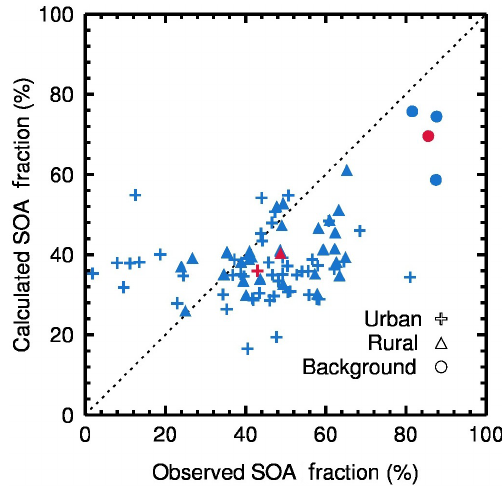
Figure 13. Comparisons between the NT-SOA module predicted and filter-measured daily SOA mass fraction in OA at urban, rural, and background sites during the simulation episode.